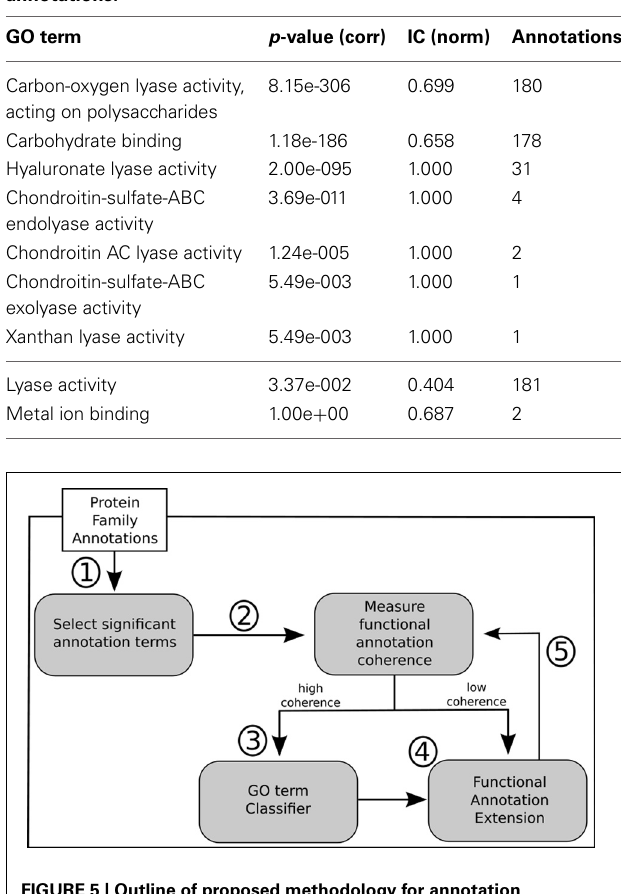
FIGURE 5 | Outline of proposed methodology for annotation